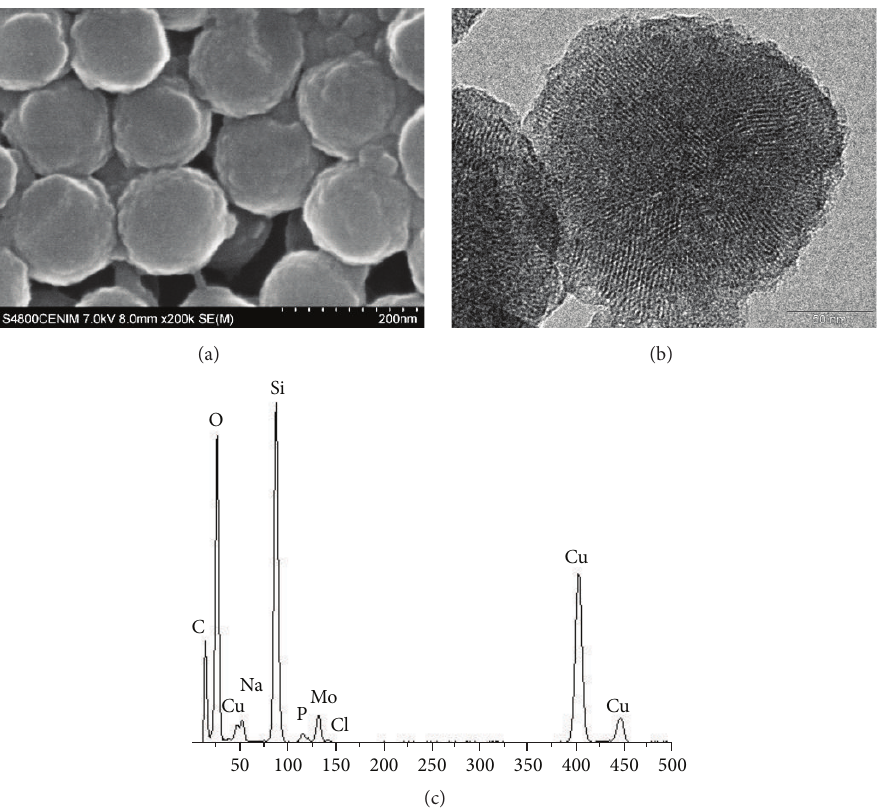
Figure4:SEMimage(a),TEMimage,(b)andEDXanalysis(c)oftheSiO 2 mesoporousnanoparticlesloadedwithsodiumphosphomolybdate and encapsulated by a PDDA layer.